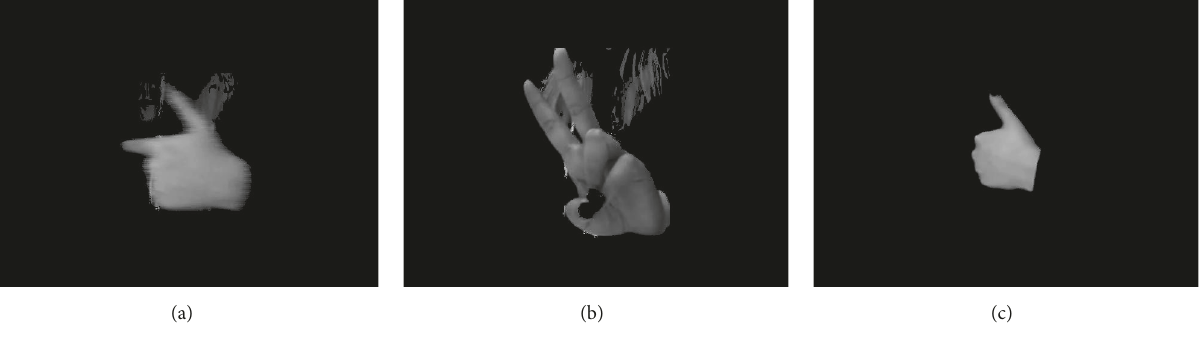
Figure 26: Examples of misclassified postures.